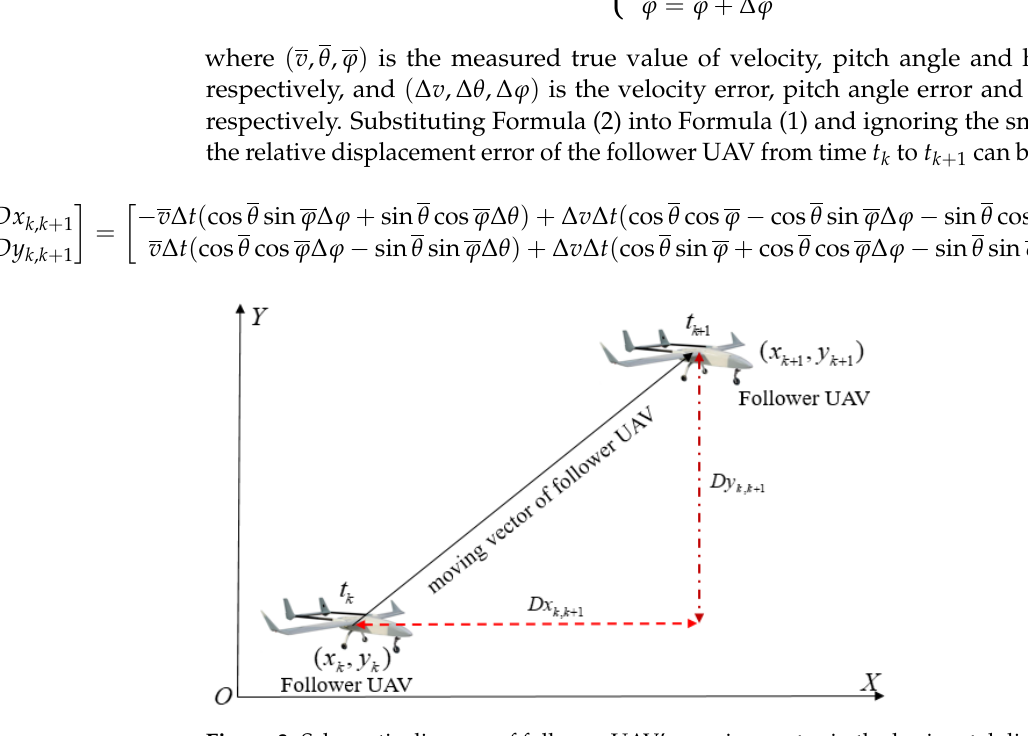
Figure 3. Schematic diagram of follower UAV’s moving vector in the horizontal direction.